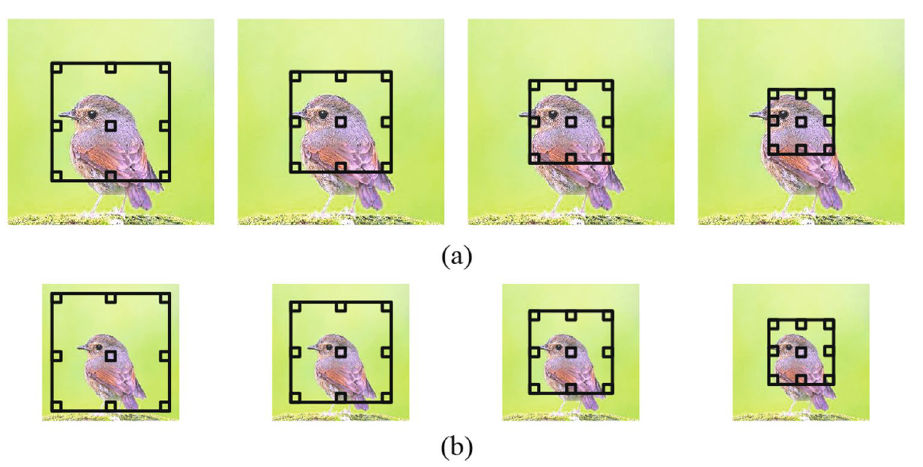
Figure 3. Feature in atrous spatial pyramid pooling (ASPP) on the image in CASIA II 33 dataset: ( a ) original image and ( b ) image is scaled by